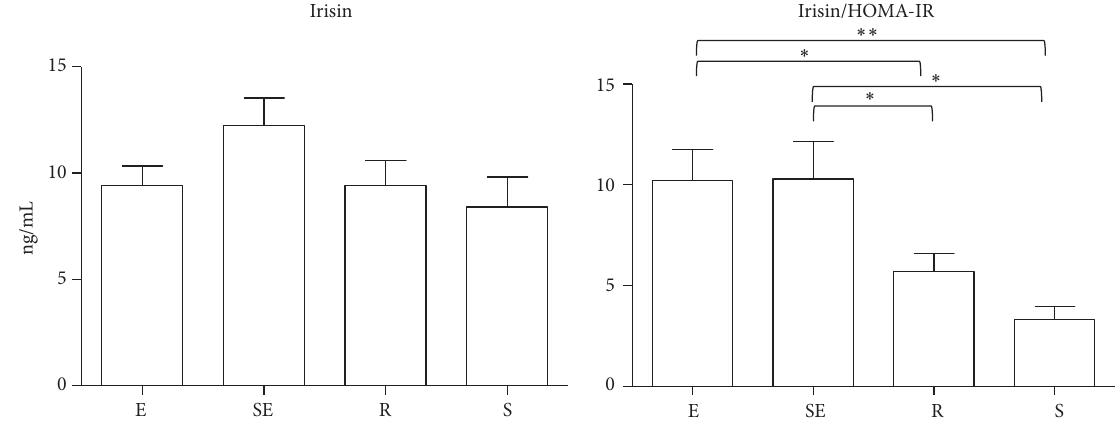
Figure 2: Irisin and irisin/HomeOstasis Model Assessment for estimating insulin resistance (HOMA-IR) ratio levels in differently trained subjects. Irisin and irisin/HOMA-IR ratios were evaluated in elite (E), subelite (SE), recreational (R), and sedentary (S) subjects. ∗ 𝑝 < 0.05 ; ∗∗ 𝑝 < 0.01